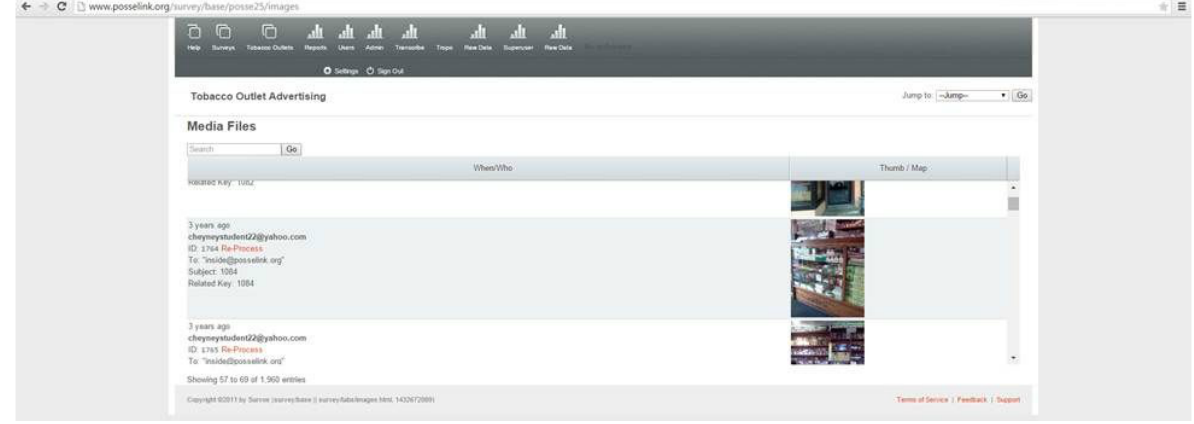
Figure 6. Back-End Database with Photographs from Data Collection.